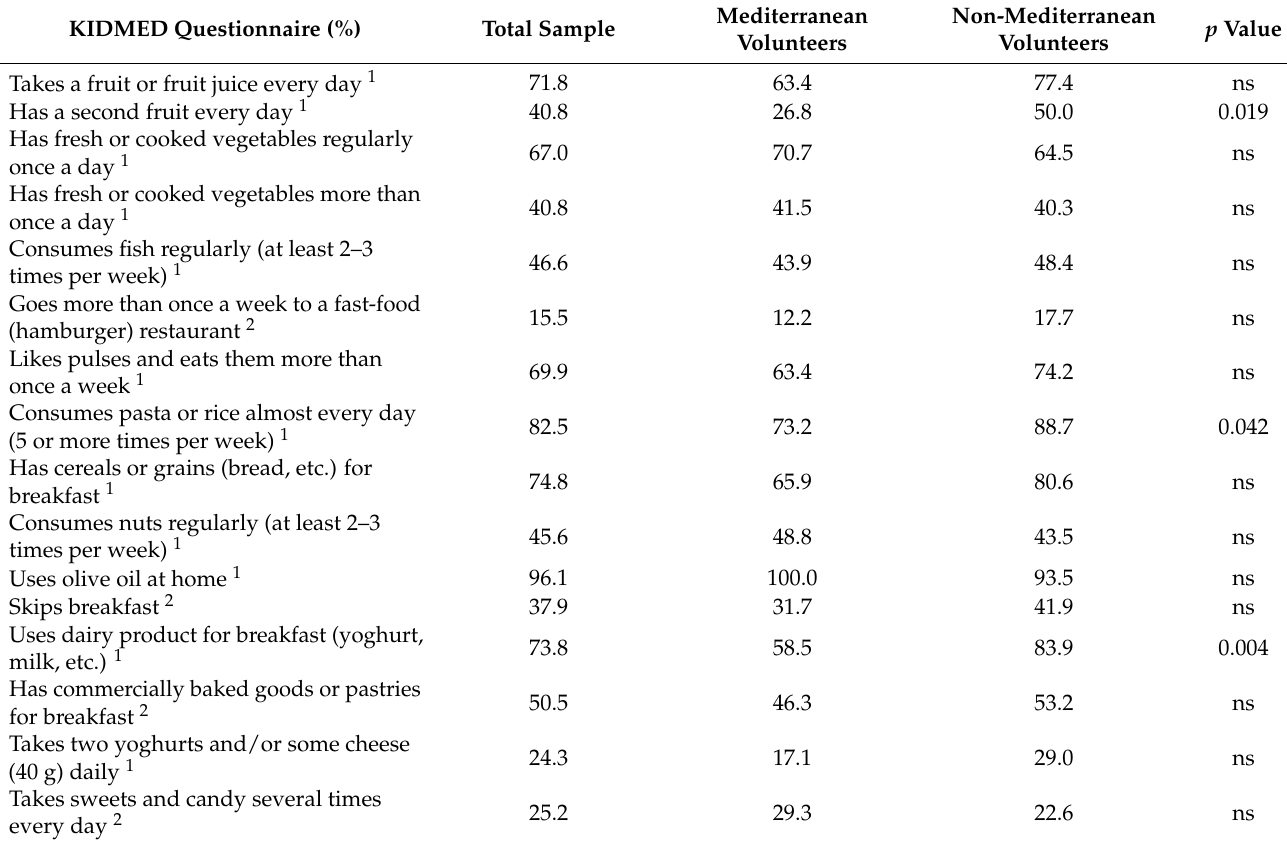
Table 9. Responses to the KIDMED questionnaire by geographical area of